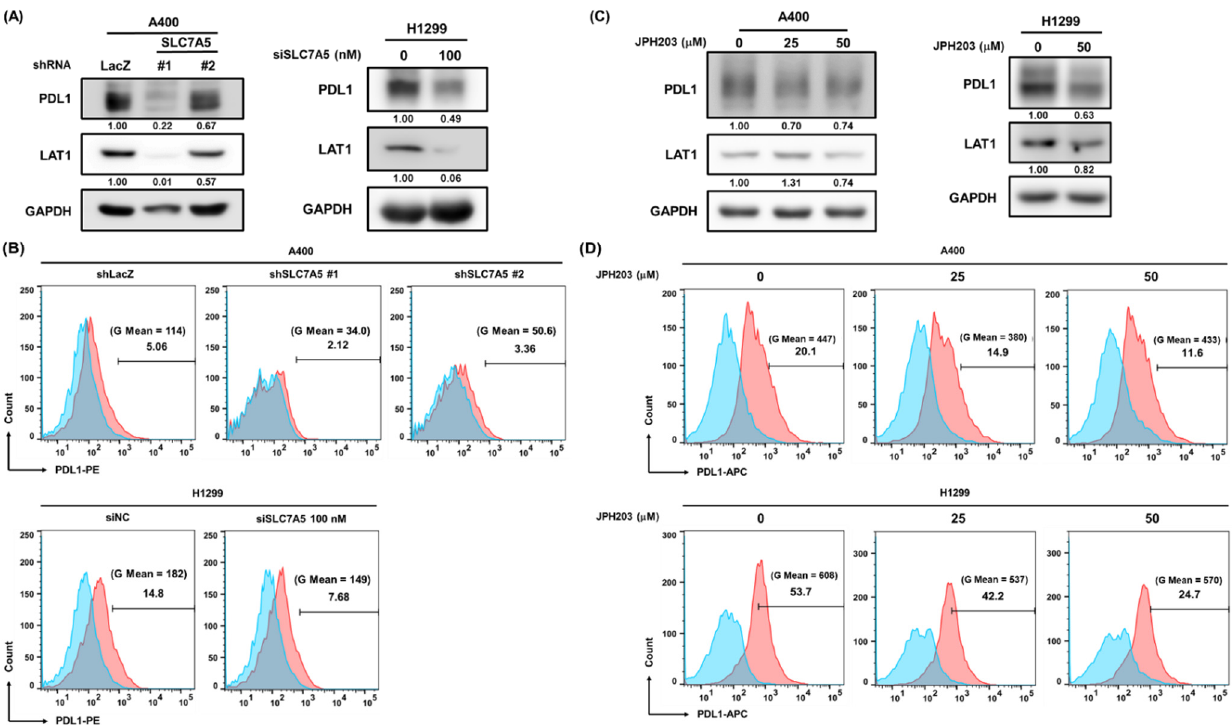
Figure 4. LAT1 activity participates in PD-L1 expression on NSCLC cells. ( A , B ). The knockdown of LAT1 by lentiviral delivery of LAT1-specific shRNAs (shSLC7A5#1 or shSLC7A5#2) for A400 cells or by transfection of LAT1-specific siRNA oligonucleotides (si-SLC7A5) for H1299 cells was confirmed by Western blot analysis ( A ). The cell surface expressions of PD-L1 were determined by Western blot ( A ) or FACS analysis ( B ), respectively. The FACS data was analyzed by FlowJo software. The inserted numbers in ( A ) represent the relative expression levels of PD-L1 or LAT1 in comparison to the sh-LacZ or si-NC (indicated as 0 nM) control group, respectively, after normalization with GAPDH. Blue peaks and red peaks in ( B ) represent an isotype control and an anti-PD-L1 antibody, respectively. siNC, negative control siRNA. ( C , D ) The PD-L1 total protein and cell surface expressions of A400 and H1299 cells under JPH203 treatment were determined by Western blot ( C ) and FACS analysis ( D ), respectively. The inserted numbers in ( A ) present the relative expression levels of PD-L1 or LAT1 in comparison to the 0.1% DMSO control group (0 μ M) after normalization with GAPDH. Blue peaks and red peaks in ( D ) represent an isotype control and an anti-PD-L1 antibody, respectively.